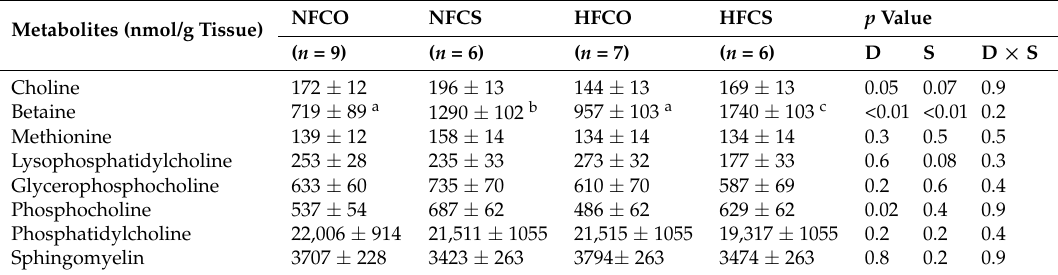
Table 3. Choline-derived metabolite concentrations in the fetal liver at gestational day 17.5 1 . Metabolites (nmol/g Tissue)